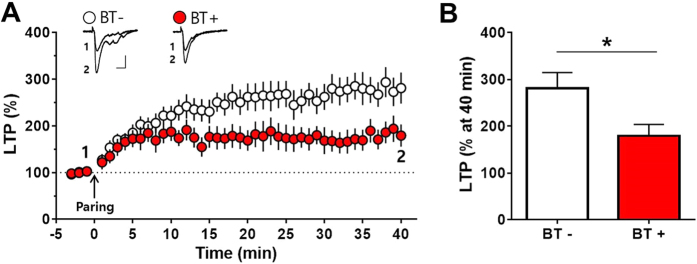
IA learning occludes pairing-induced LTP in the implanted HiB5 cell-derived neurons ex vivo.(A) Slices were prepared from homecage control (BT−) and IA-learned rats (BT+). LTP was induced by paring protocol indicated by the arrow: eighty presynaptic stimuli were delivered at 2 Hz while holding the membrane potential at +10 mV. Insets demonstrate averaged current traces of five consecutive EPSC responses at the indicated time. Scale bars, 20 ms and 50 pA. (B) The magnitudes of LTP were compared at 40 min after the pairing. LTP after IA learning (BT+) was significantly attenuated. *P < 0.05, unpaired Student’s t-test. Values are mean ± SEM.